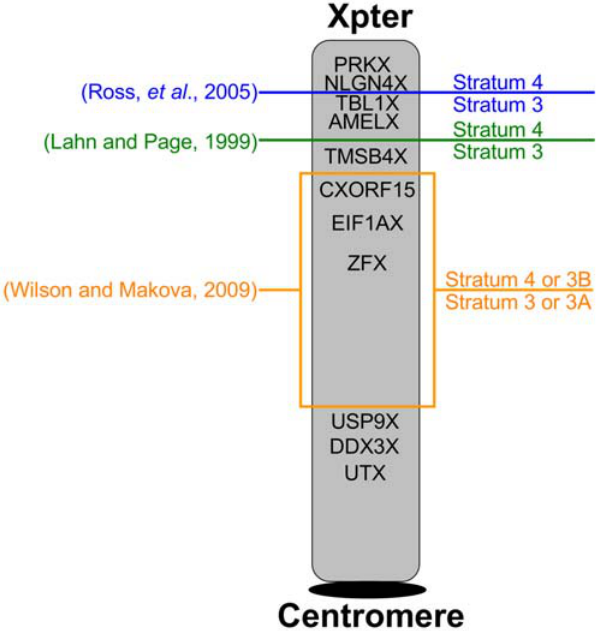
Figure 4. New stratum boundary. The previous descriptions of the stratum3–stratum4 boundary are shown, along with a new boundary region, identified by this study.